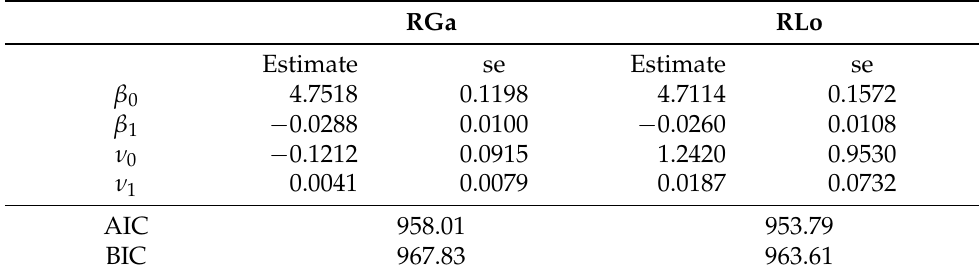
Table 2. Estimated parameters in mineral data set.